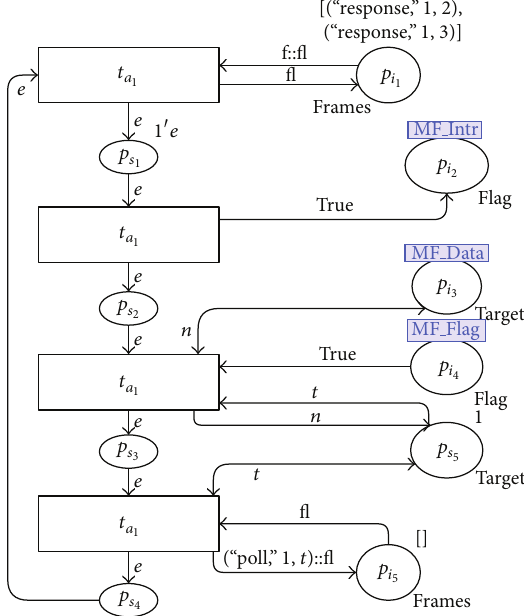
Figure 8: The ARM system’s CPN model.